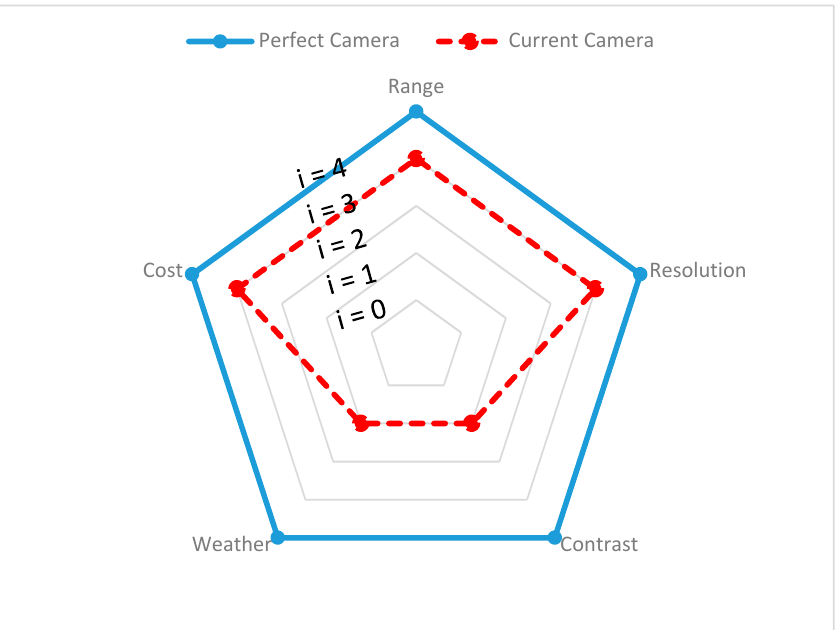
Figure 9. Camera sensor spider chart. The difference between the red dashed line and the solid blue line is the performance gap.